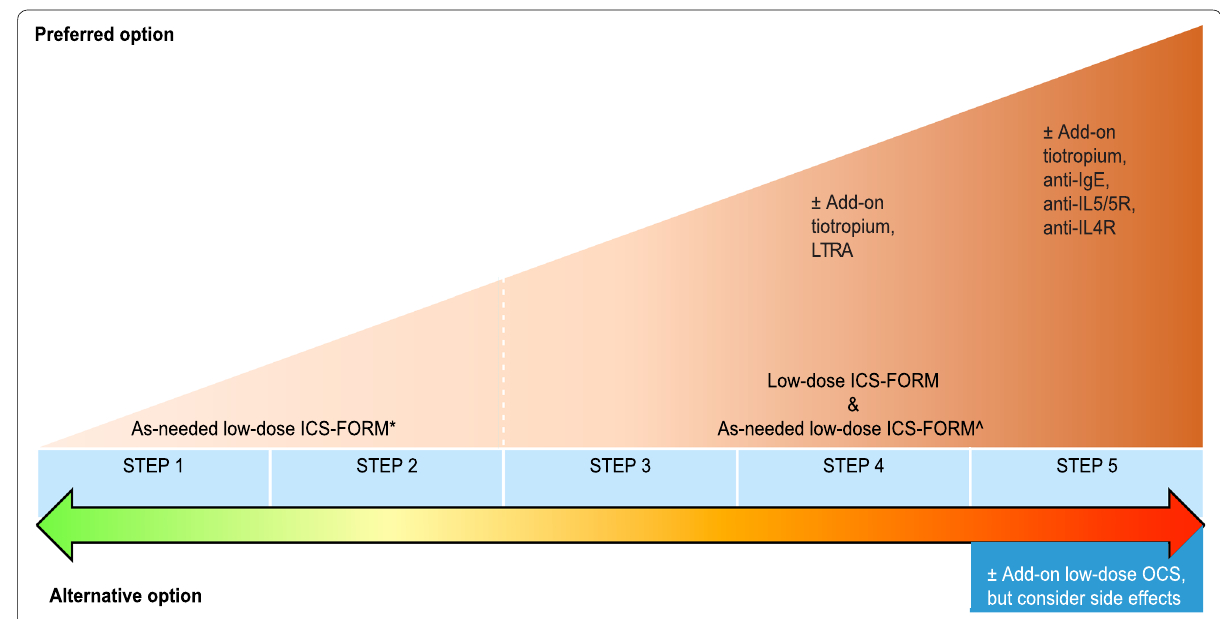
Fig. 6 Symptom‑driven approach. ICS inhaled corticosteroids, FORM